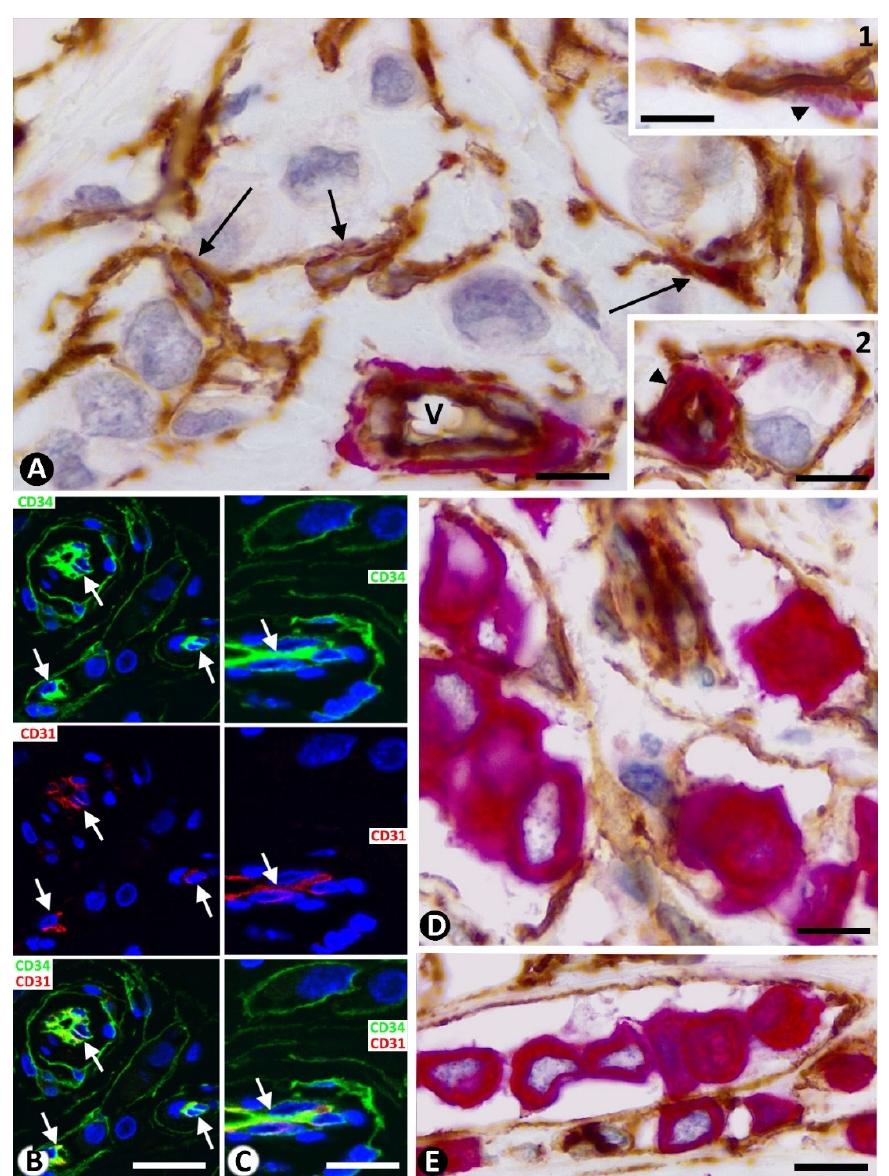
Figure 2. ( A ) and inserts: Double immunochemistry staining for CD34 (brown) and α SMA (red). Haematoxylin counterstain. Vessels (V) and stromal cells (arrows) are observed around neoplastic cells (Haematoxylin-stained nuclei). The expression of CD34 is more intense in ECs than in stromal cells. Pericytes (arrowhead) are observed around ECs (insert 1 and 2 ). ( B , C ): Double immunofluorescence labelling for CD34 (green) and CD31 (red) with DAPI counterstain. Vessels (arrows), stromal cells (green) and nuclei of neoplastic cells are observed. Note CD34/CD31 coexpression in vessel ECs, while the stromal cells only express CD34. ( D , E ): Double immunochemistry staining for CD34 (brown) and Cytokeratin AE1/AE3 (red). Haematoxylin counterstain. Presence of neoplastic cells immunostained with anti-cytokeratin AE1/AE3 (red), surrounded by CD34+ stromal cells (brown). Bar: ( A , D , E ): 10 µm; ( B , C ): 30 µm; Insert 1 and 2 of ( A ): 20 µm.